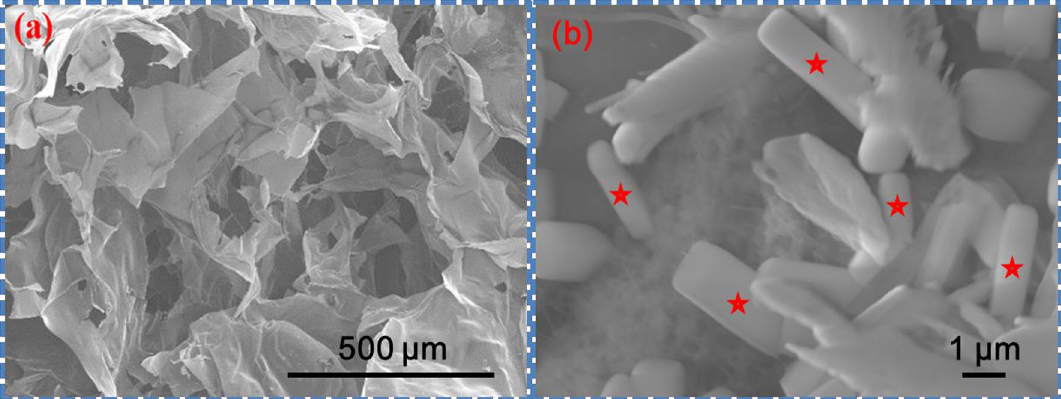
Figure 2. ( a ) Top view SEM image of SGNR, ( b ) Magnified image of SGNR clearly indicates GNRs (showed by Heat shock protein response. Staining of control, HSP 27, HSP 70 and HSP 90 in RC are done by Immu- nofluorescence. Briefly, cells were fixed in methanol for 30 minutes at − 20 °C, washed with PBS, and incubated in blocking solution (10% Bovine serum albumin in PBS) for 1 h at room temperature. Cells were stained with goat anti-rabbit IgG HRP-conjugated antibody diluted in blocking solution for 12 h at room temperature in humidified chambers. Cells were washed with PBS and then incubated with secondary antibody diluted 1/200